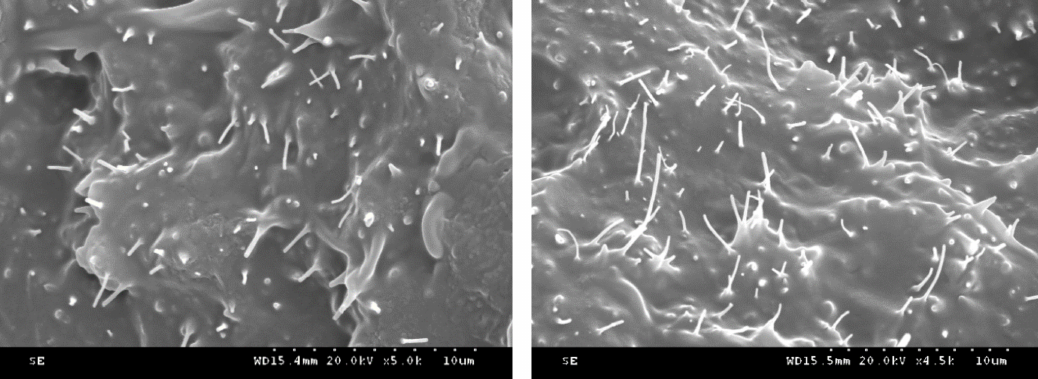
Figure 9. SEM images of different parts of CP1.4-5 CNFPUC